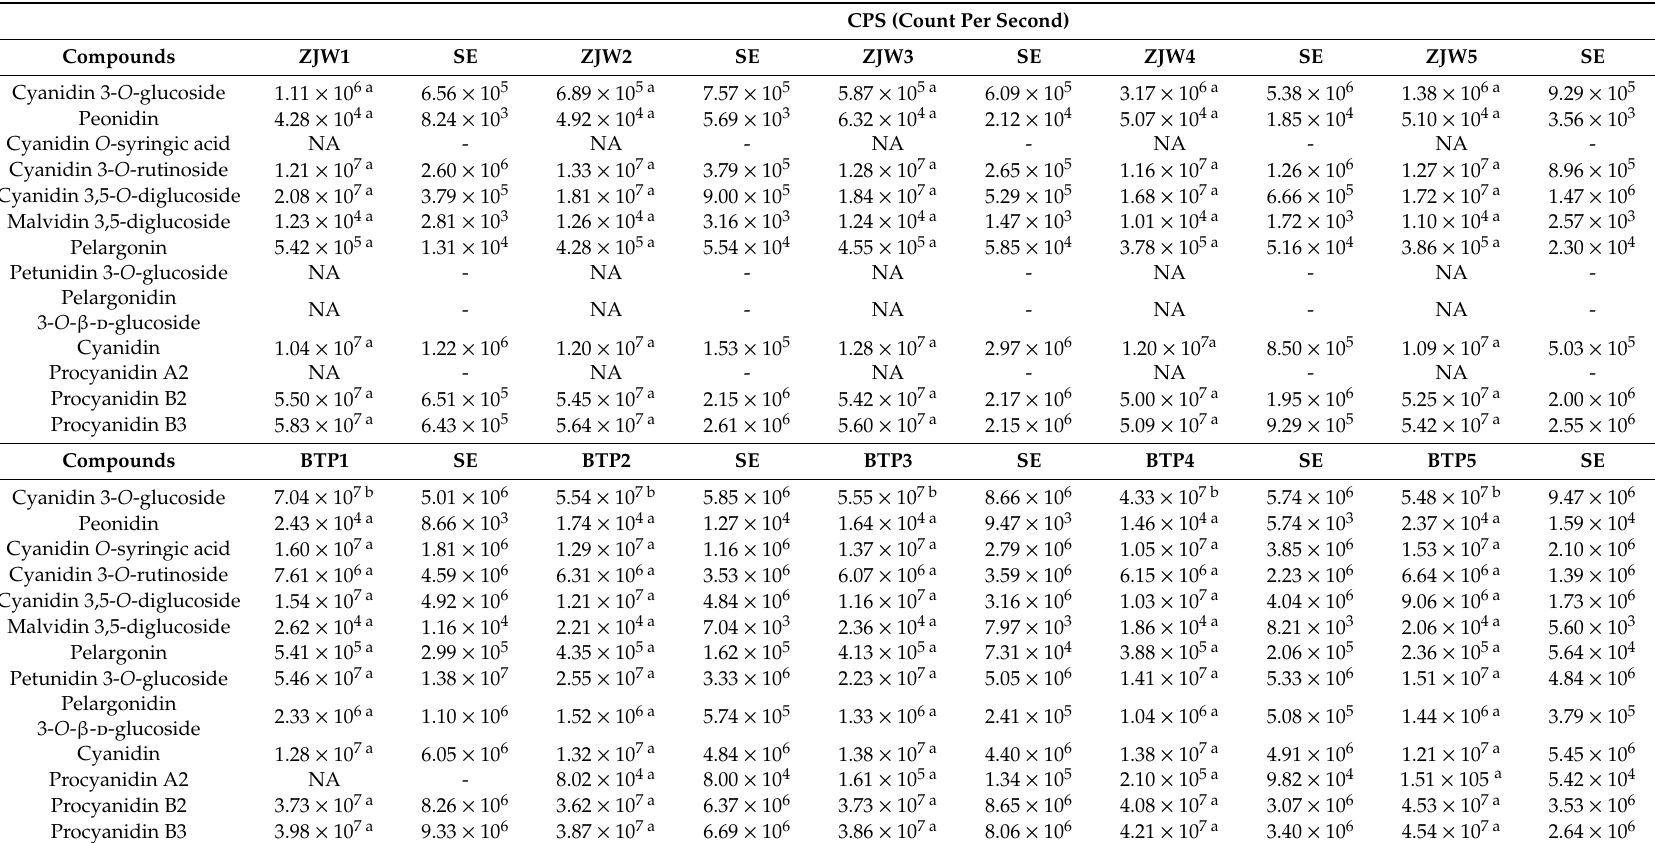
Table 1. Type and content of anthocyanins in white (ZJW) and pink (BTP) during tea flower